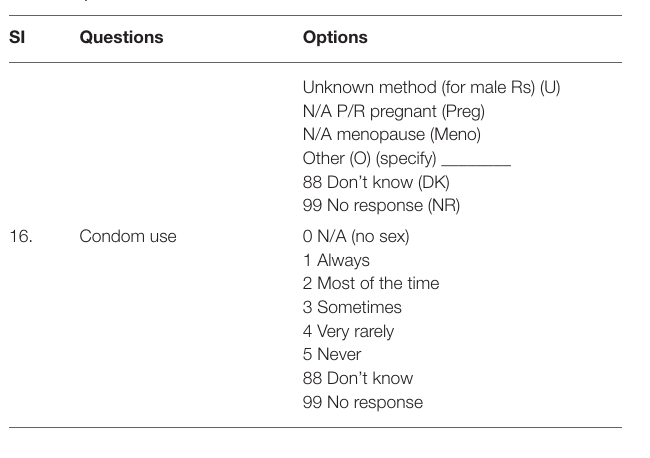
TABLE 3 | Questionnaire related to health behavior.